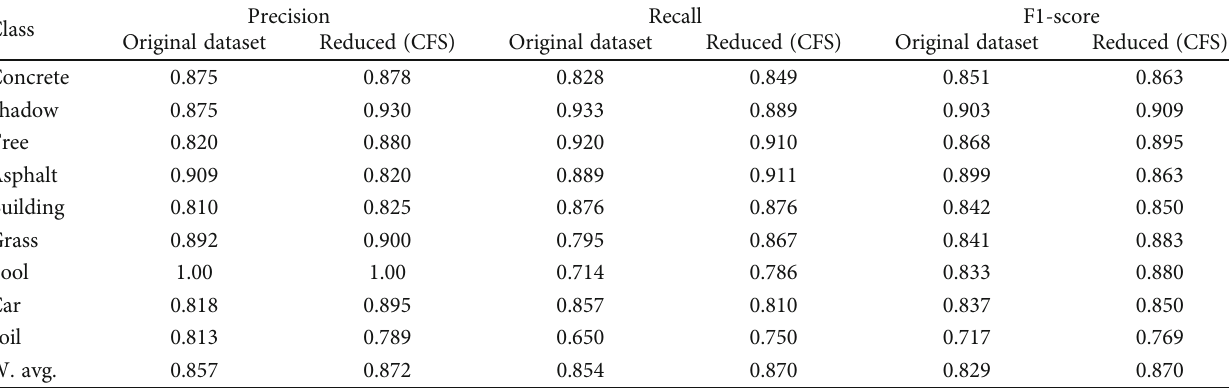
Table 4: Precision, recall, and F1-score for the original and the best reduced dataset using RF classi fi